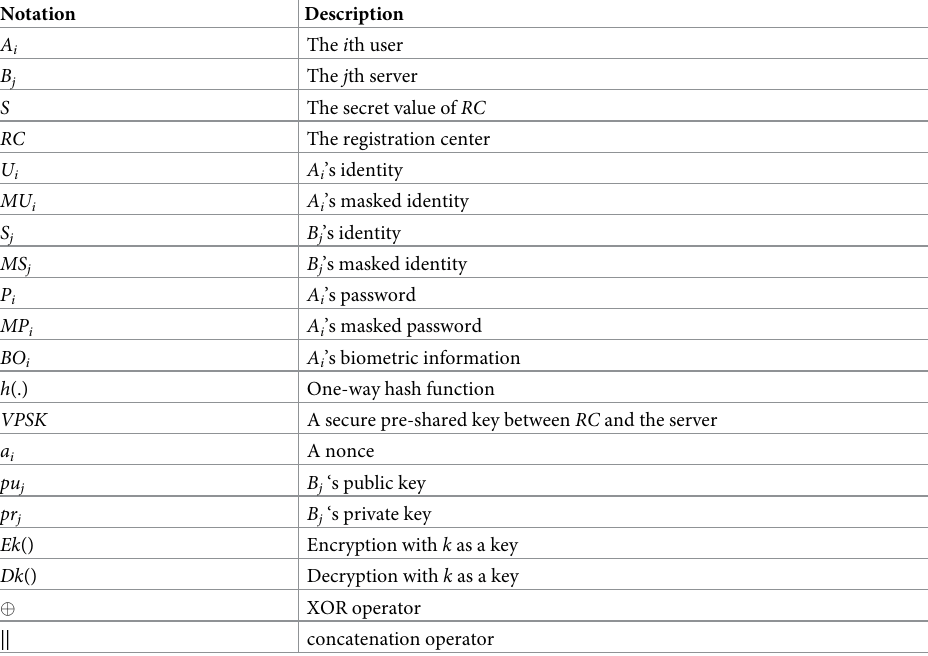
Table 1. Notations in Lwamo et al.’s